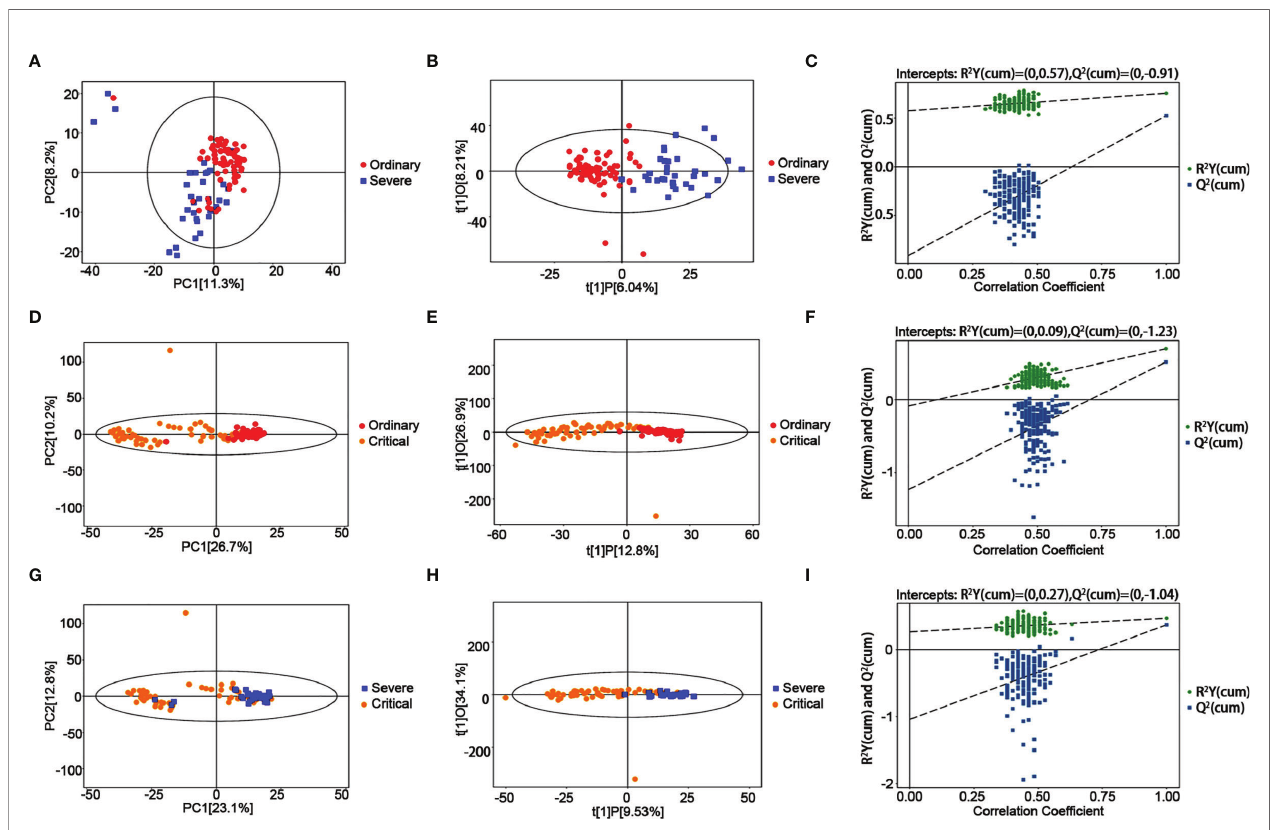
FIGURE 3 | Metabolomic alternations between the severe group and ordinary group as COVID-19 progresses. (A) PCA analysis. (B) OPLS-DA analysis. (C) Permutation analysis. Metabolomic alternations between the critical group and ordinary group. (D) PCA analysis. (E) OPLS-DA analysis. (F) Permutation analysis. Metabolomic alternations between the critical group and severe group. (G) PCA analysis. (H) OPLS-DA analysis. (I) Permutation analysis.